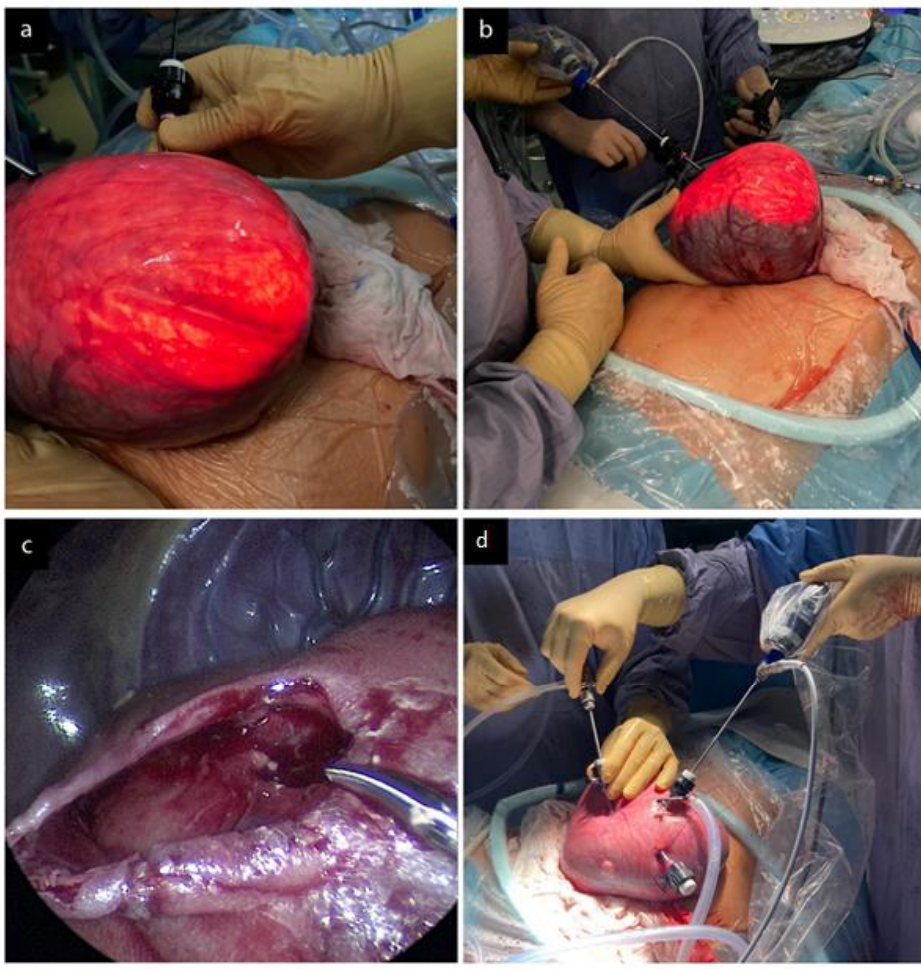
Figure 3. Laparotomy-assisted fetoscopic MMC repair: ( a ) Exteriorized uterus with the first port. The uterine cavity is infused with humidified CO 2 ; ( b ) Optical ports are placed in the uterus; fetal positioning; ( c ) Visualization of the opened MMC with the skin-muscle patch. The grasper points to the medullary cone (TSC) positioned at L5 (performed by A. Pastuszka, M.D., Ph.D.); ( d ) Three ports are placed in the uterus during fetoscopic MMC repair.